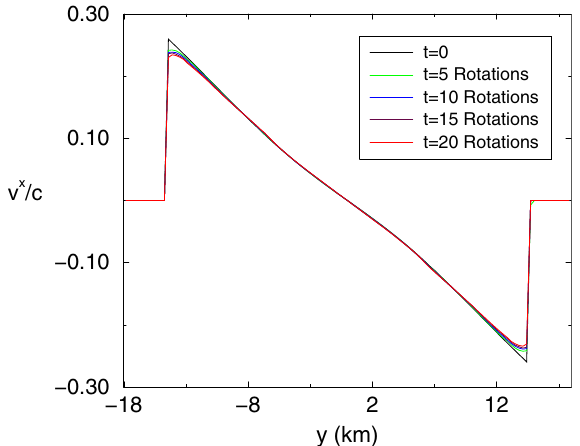
Fig. 22 Time evolution of the rotational velocity profile for a stationary, rapidly rotating relativistic star (in the Cowling approximation), using the 3rd order PPM scheme and a 116 3 grid. The initial rotational profile is preserved to a high degree of accuracy, even after 20 rotational periods. (Image reproduced with permission from Stergioulas and Font 2001, copyright by